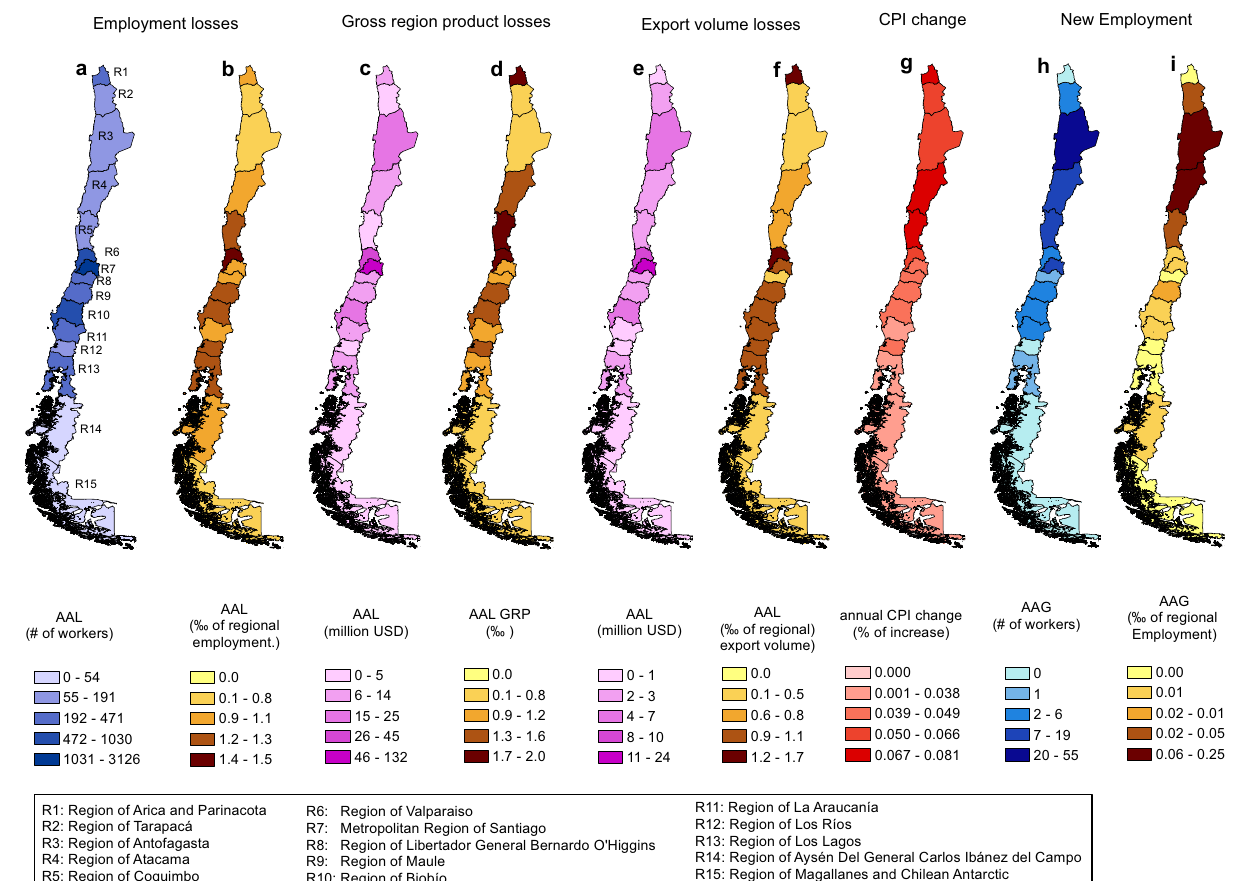
R11: Region of La Araucanía R1: Region of Arica and Parinacota R6: Region of Valparaiso R12: Region of Los Ríos R2: Region of Tarapacá R7: Metropolitan Region of Santiago R13: Region of Los Lagos R3: Region of Antofagasta R8: Region of Libertador General Bernardo O'Higgins R14: Region of Aysén Del General Carlos Ibánez del Campo R4: Region of Atacama R9: Region of Maule R15: Region of Magallanes and Chilean Antarctic R5: Region of Coquimbo R10: Region of Biobío Fig. 6 New risk indicator for Chile. a , b Show the Average Annual Loss (AAL) of employment by region of Chile in number of workers and as a fraction (per thousand) of the corresponding regional employment. c , d Show the AAL of Gross Regional Product (GDP) in millions of dollars and relative terms. e , f Show the AAL of export volume by region in millions of dollars and as a fraction (per thousand) of the regional export volume. g Shows the average annual change of the Consumer Price Index (CPI) by region of Chile. h , i Show the Average Annual Gain (AAG) of employment by region in number of workers and as a fraction (per thousand) of the regional